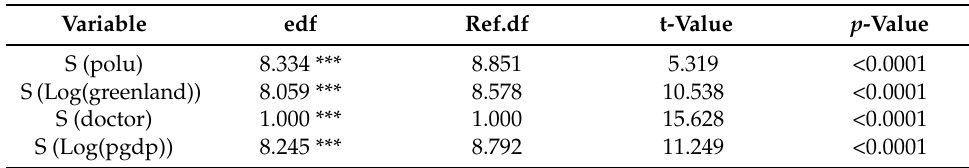
Table 7. The nonlinear effect result of environmental status on mortality.